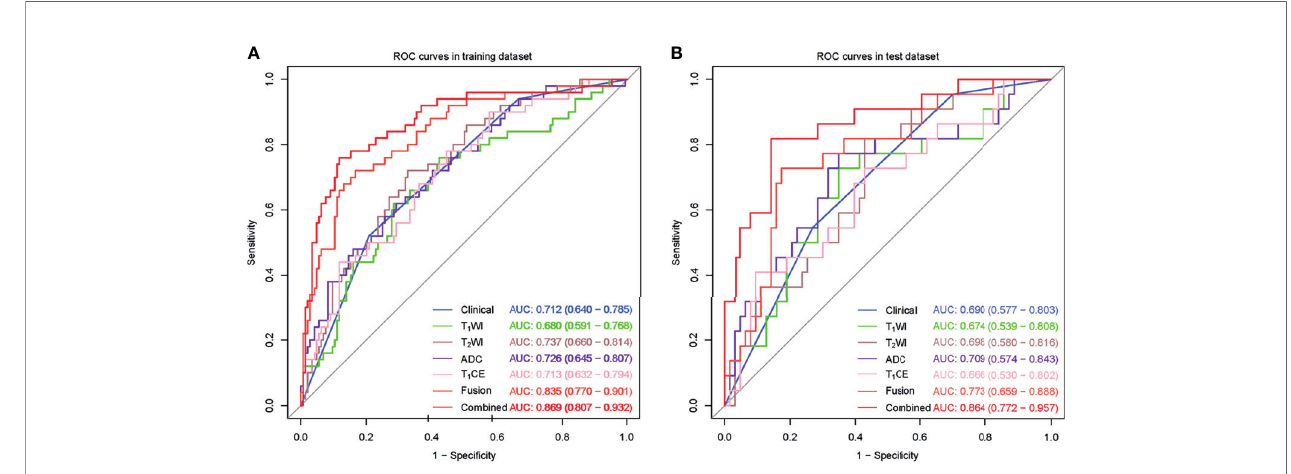
FIGURE 3 | ROC curves for the perineural invasion prediction of different models in the training (A) and test (B) datasets. (Clinical, the clinical model based on effective clinical and radiological variables; T 1 CE, the T 1 CE radiomics signature based on features from T 1 WI contrast-enhanced sequence; Fusion, the fusion radiomics signature based on features from the four sequences; Combined, the combined model incorporating effective clinical and radiological variables and rad- score from fusion radiomics signature together.).